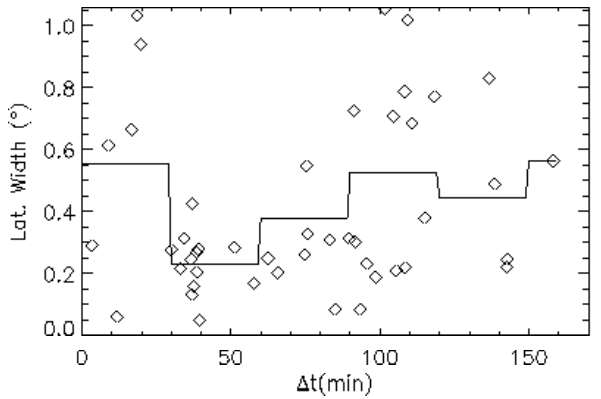
Fig. 4. Distribution of the latitudinal width of the SAID event versus time after substorm onset ( 1t ). The solid line represents the average latitudinal width calculated over 30-min intervals.